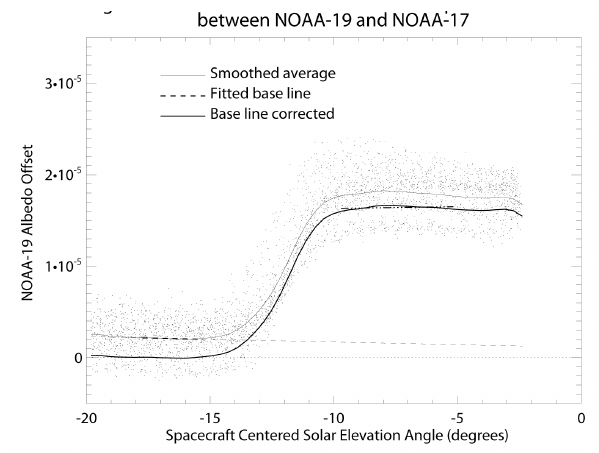
Fig. 8. Example of N19 IBSL nightside daily measurements on the nightside on day 171 of 2010. Larger IBSL errors were measured in the Northern Hemisphere in blue, and lower signals are for the Southern Hemisphere, in red. Thin solid curves are for IBSL af- ter the empirical correction of earth shine near terminator. Thick straight lines are respectively fitted between SCSEA = 6 ◦ and 10 ◦ for daily IBSL at SCSEA = 6 ◦ , and between SCSEA = 16 ◦ and 20 ◦ for daily IBSL at SCSEA = 18 ◦